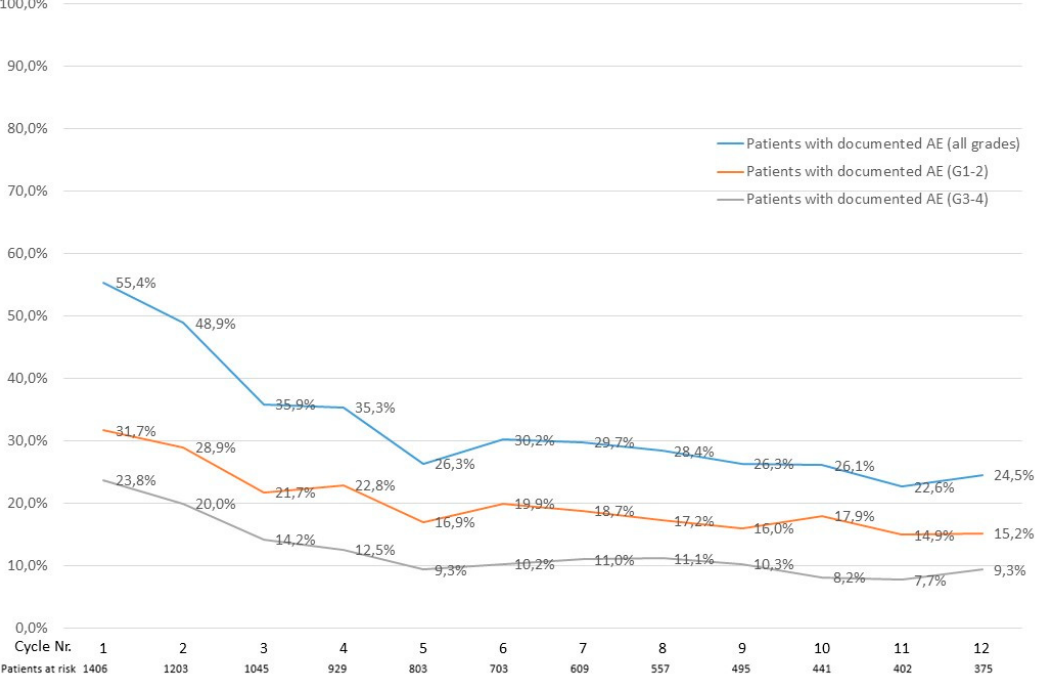
Figure 2. Percentage of patients who experienced a documented AE per azacitidine treatment cy- cle.